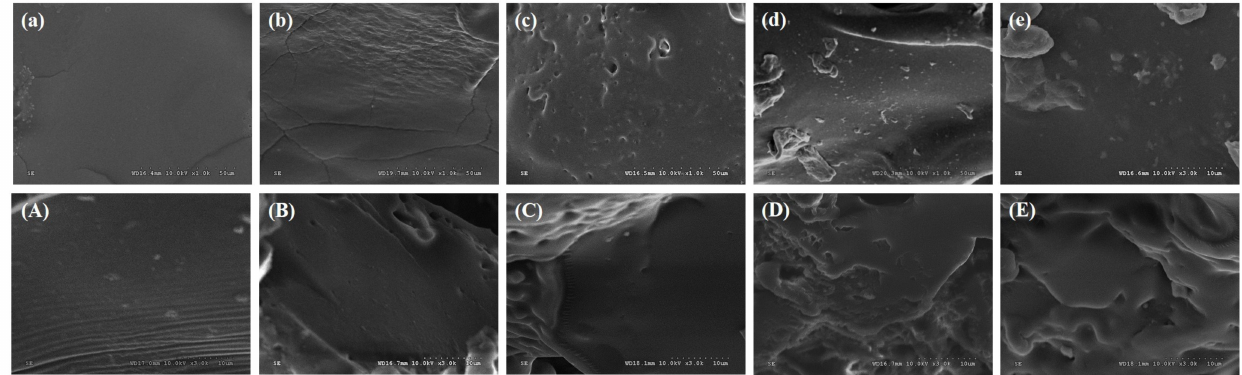
Figure 2. SEM images of ZS–Cur0 ( a , A ), ZS–Cur1 ( b , B ), ZS–Cur3 ( c , C ), ZS–Cur5 ( d , D ), and ZS–Cur7 ( e , E ). ( a – e ) demonstrate the surface area images, and ( A – E ) demonstrate the cross-section images.